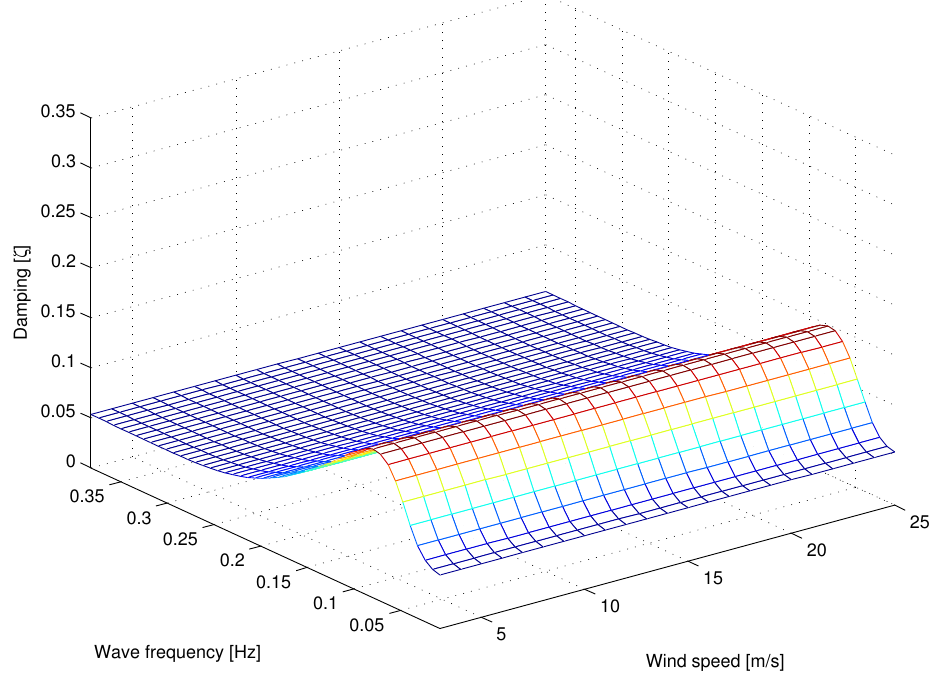
Figure 6. Open loop damping in platform roll as a function of wave frequency and wind